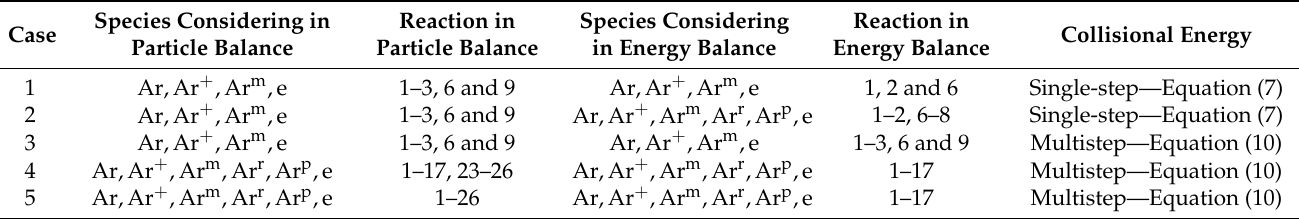
Table 2. Description of the five cases simulated in this study. The second and third columns correspond to the species and reactions rates considered in particle balance, while the fourth and fifth columns are the species and reactions included in energy balance. The reactions are listed in Table 1. The last column is the type of collisional energy equation used in each